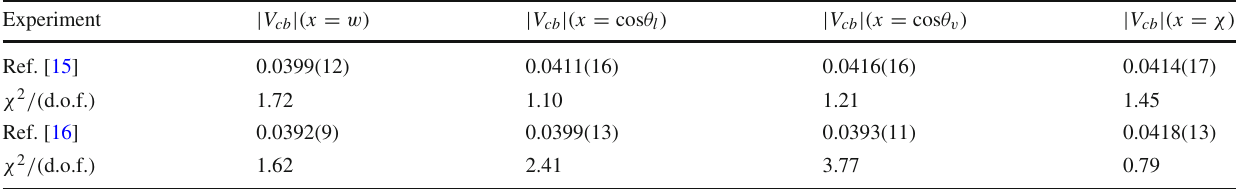
Table 1 Mean values and uncertainties of the CKM element | V cb | obtained by the correlated average (4)–(5) for each of the four kinemat- ical variables x and for each of the two experiments [15,16] adopting